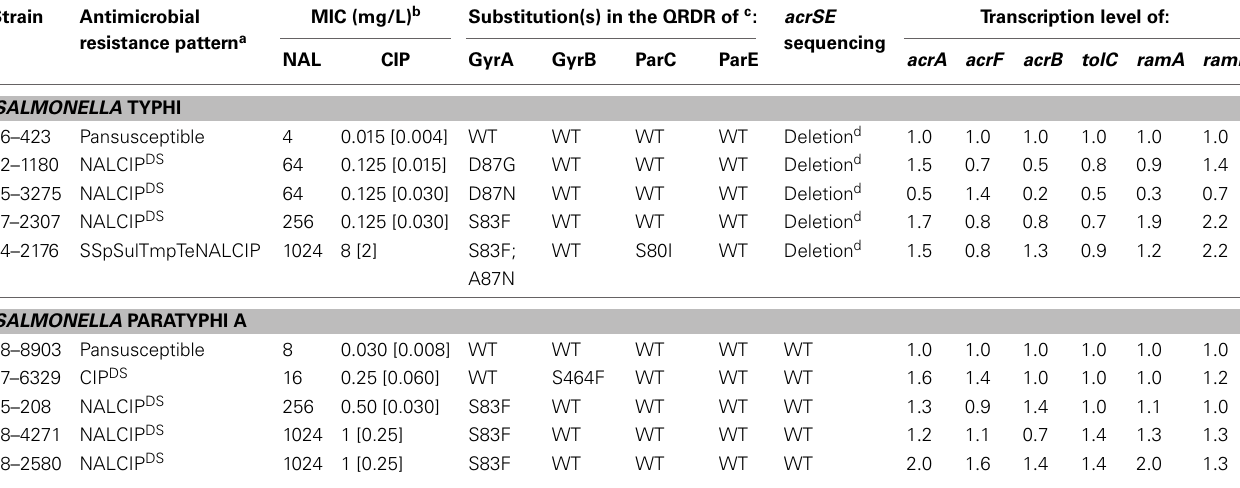
Table 3 | Study of efflux in a subset of Salmonella enterica serovars Typhi and Paratyphi A strains. Strain Antimicrobial resistance pattern